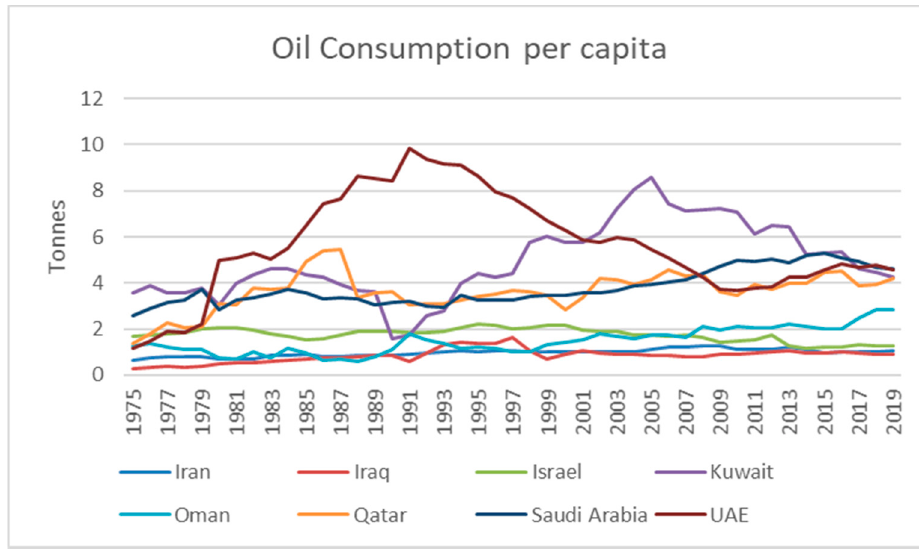
Figure 1. Oil consumption per capita.